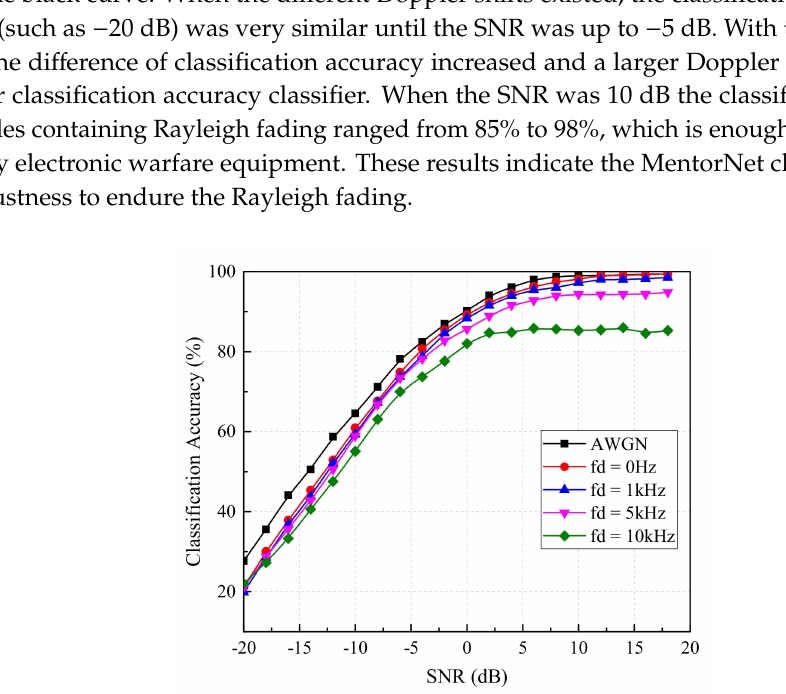
Figure 11. Classification accuracy of the MentorNet classifier under the interference of Rayleigh